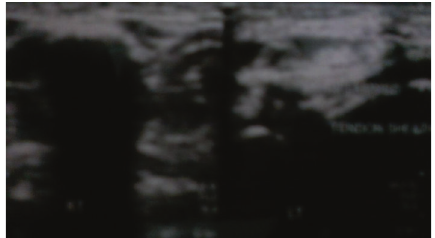
Figure 2: Color Doppler of limb showing inflamed tendon